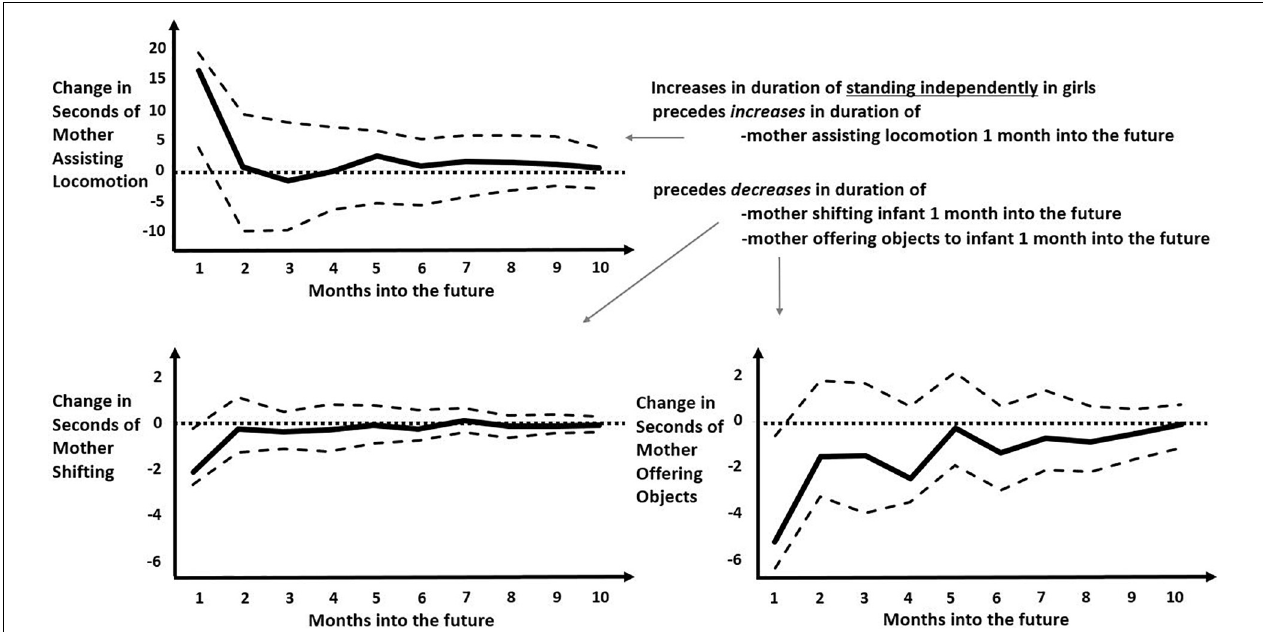
FIGURE 5 | Impulse-response functions modeling the predicted later changes in various maternal behaviors following an increase in durations of girls standing independently. Solid black curve represents the average IRF values over months into the future. Dashed lines represent the upper and lower bounds of the 95% confidence interval. Dotted lines represent zero-change. Unlike in Figure 4 , all predicted later responses are relatively small and all persist only 1 month into the future, with small increase in predicted duration of “mother assisting locomotion” (top left) and small decreases in predicted duration of “mother shifting” or “mother offering objects” (bottom left and bottom right, respectively).